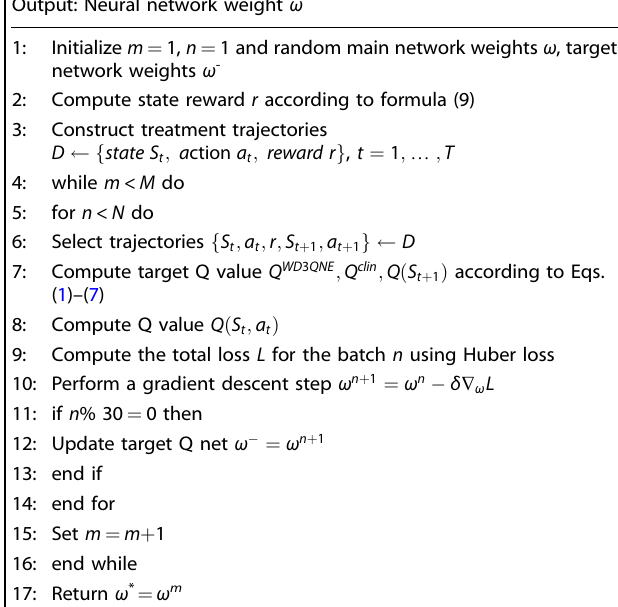
ji indicates the number of correct classi after perturbation.